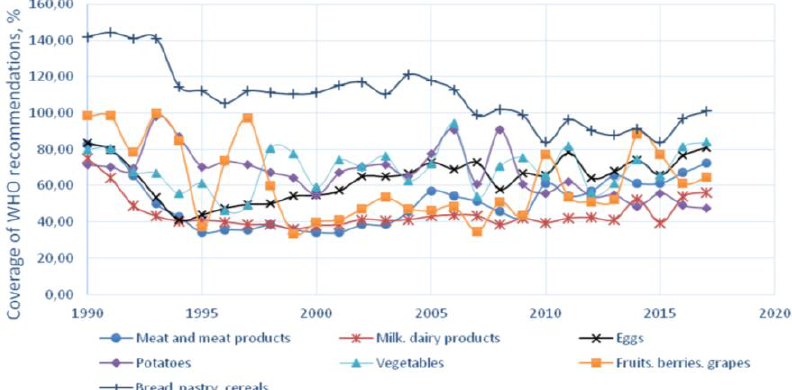
Figure 1. Food requirements coverage (%) in Moldova according to WHO